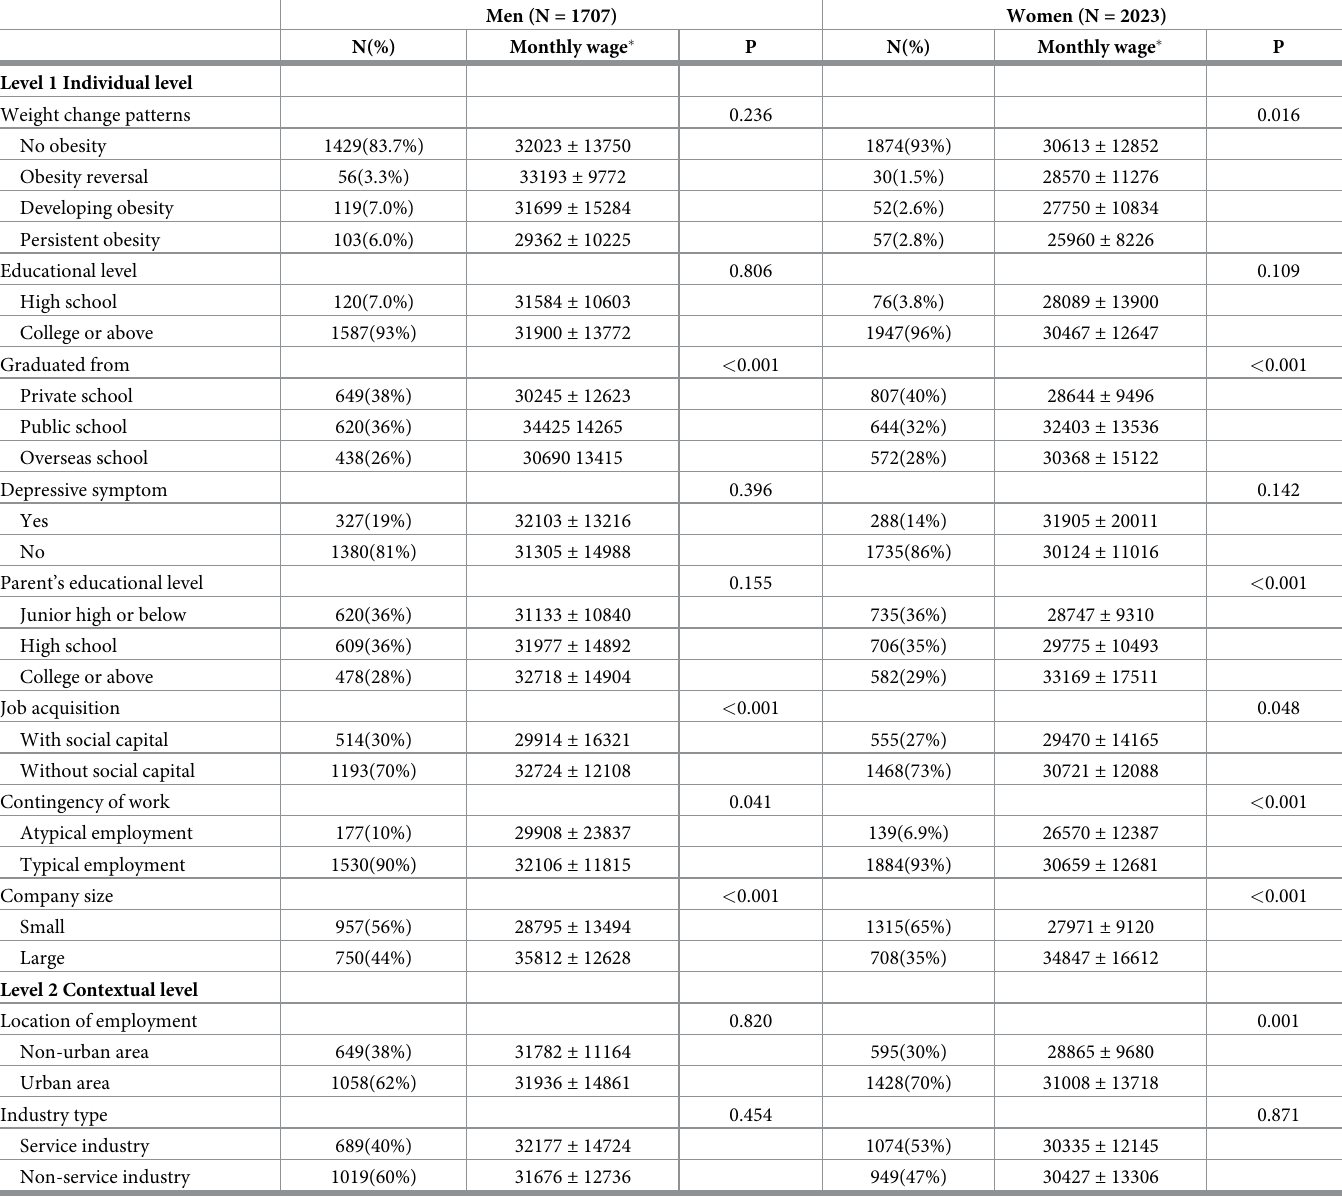
Table 1. Descriptive statistics of study participants (N =